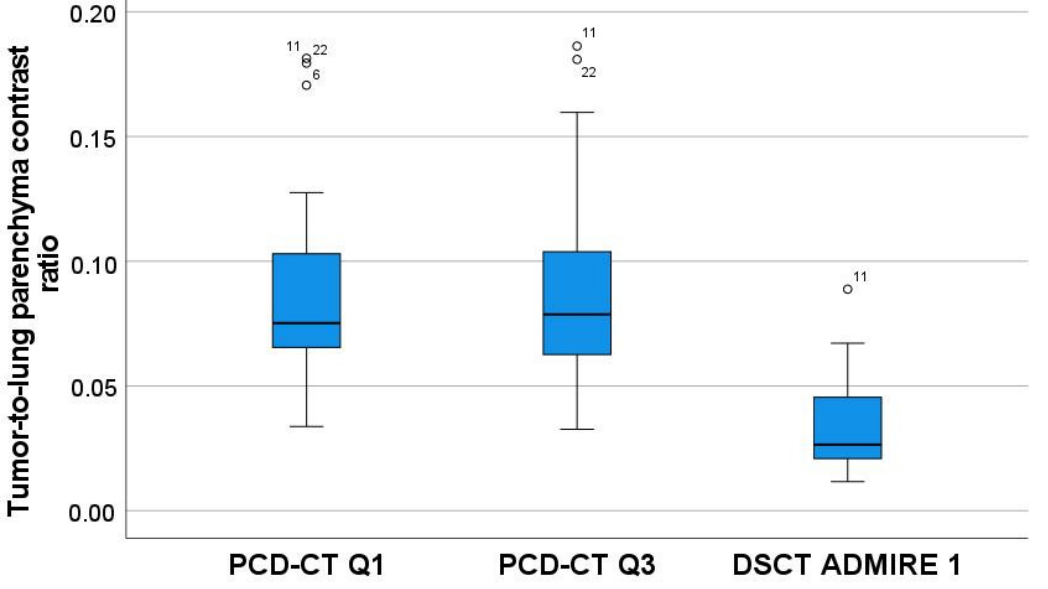
Figure 2. Boxplots representing the ratios of tumor-to-lung parenchyma contrast calculated for the two scanners, including the two Quantum strengths (Q1 and Q3) for the PCD.